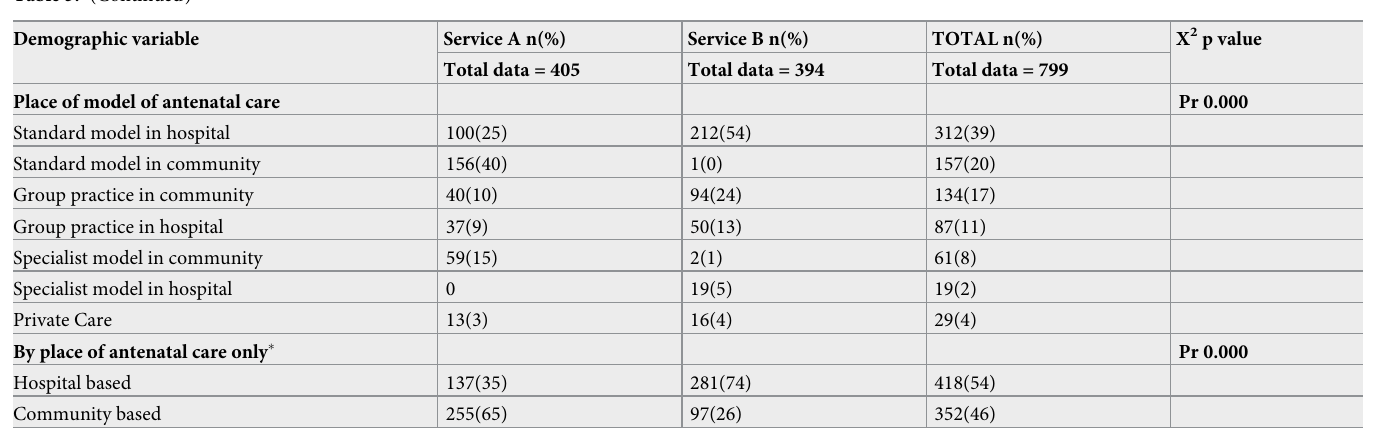
Table 4. Maternal birth outcomes and model of care. Birth outcome Model of Care No. of women (%) Unadjusted RR Model 1